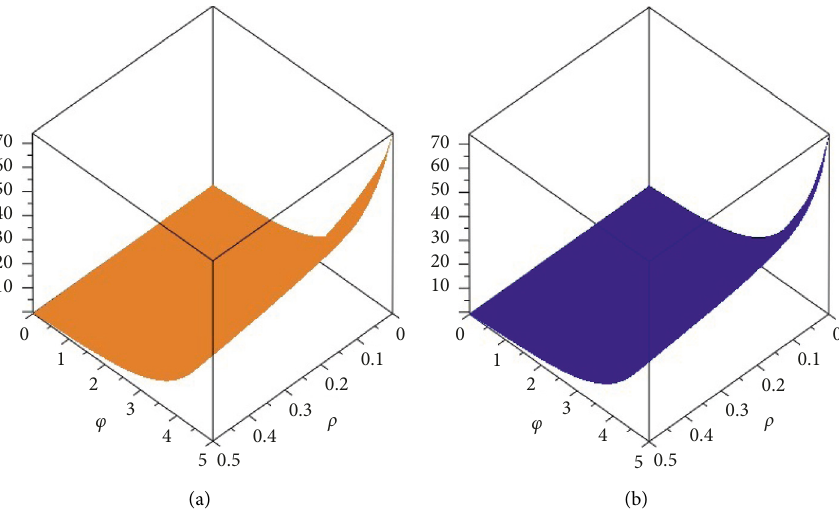
Figure 2: The graph shows the fractional order at δ � 0 . 6 and 0.4.